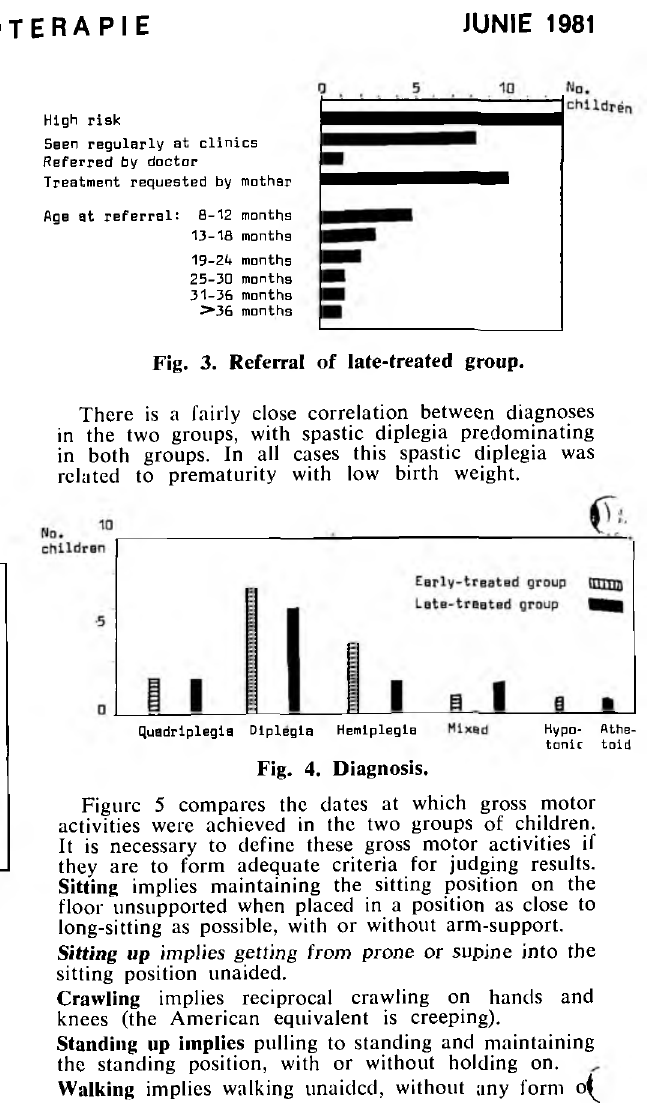
Fig. 2. Predominant sign at time of referral.